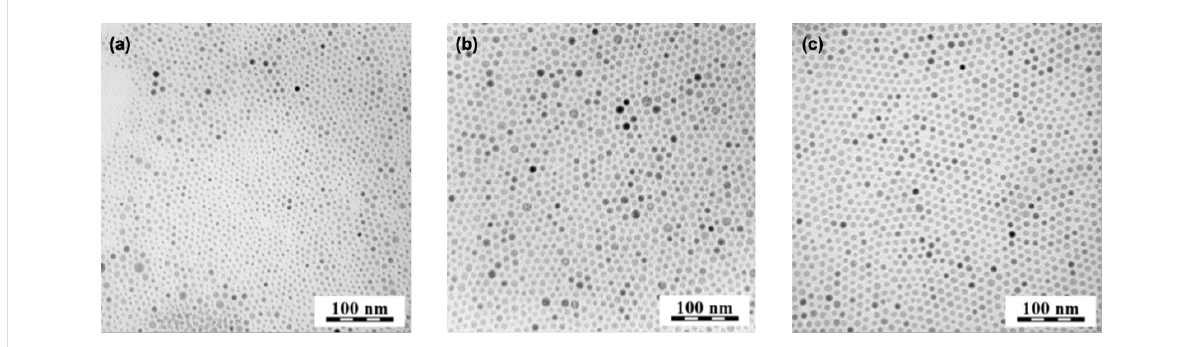
Figure 1: TEM micrographs of OM-NaYF 4 :Yb 3+ /Er 3+ nanoparticles prepared at (a) 250, (b) 300 and (c) 350 °C for 1 h.